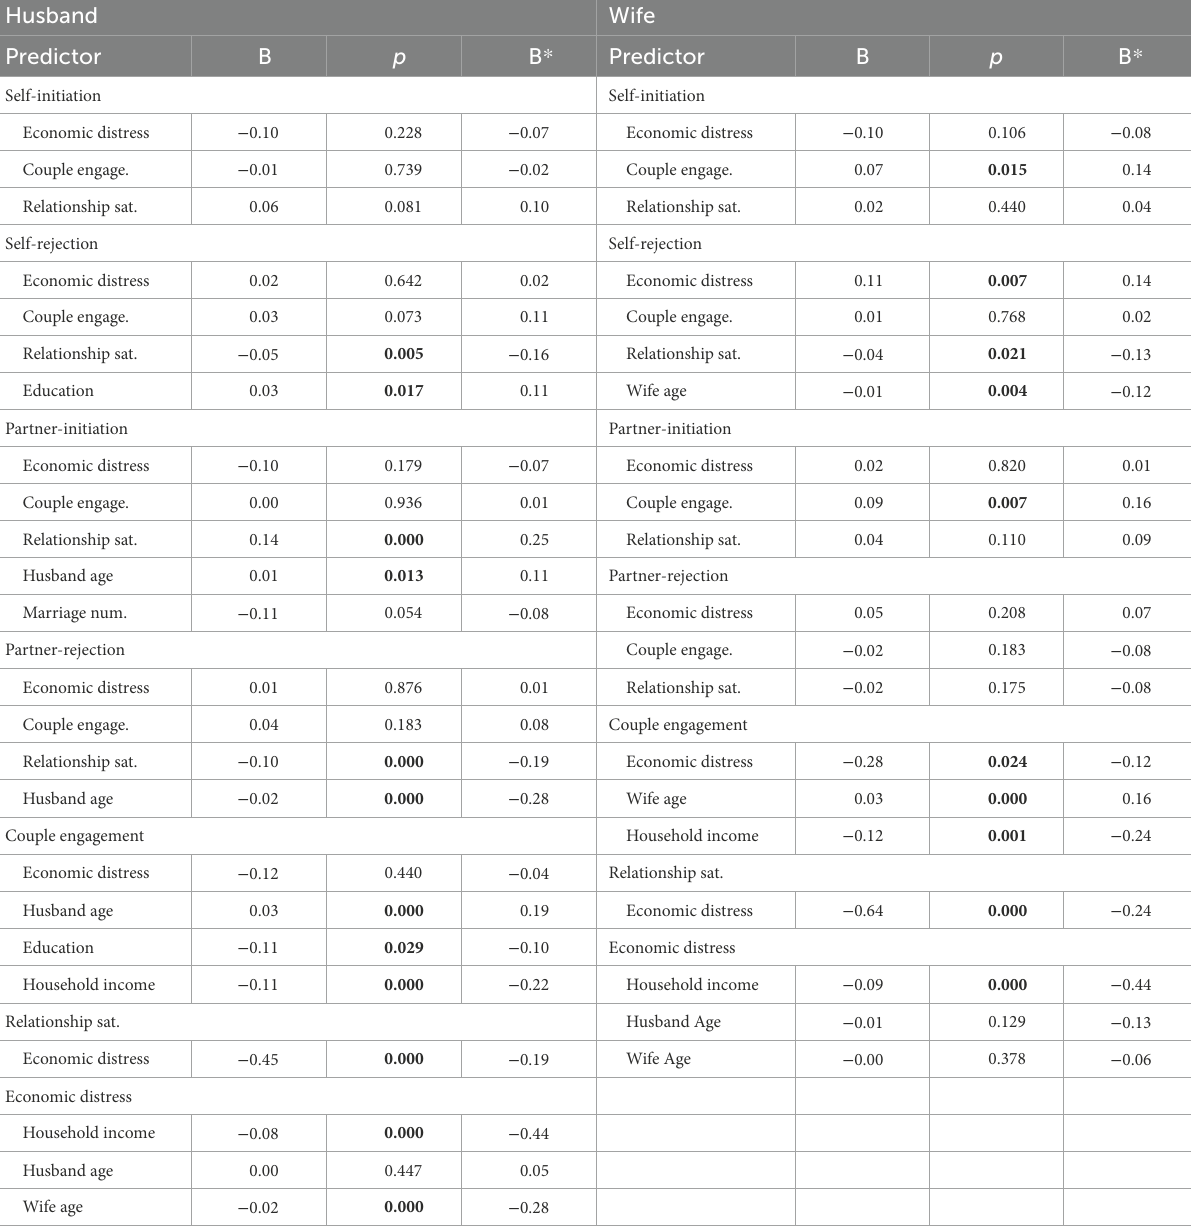
TABLE 2 Regressions from the final model. Husband Wife Predictor